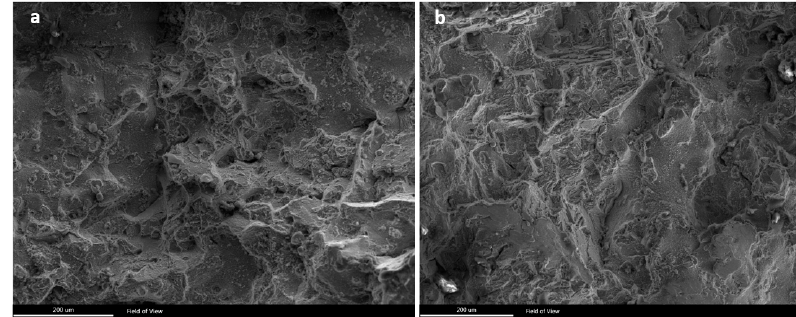
Figure 7. ( a , b ) SEM micrographs of fracture surface of the blade, broken from the airfoil.